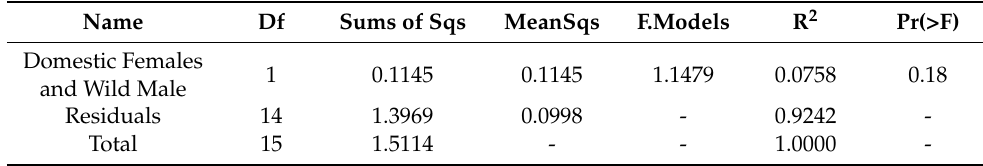
Table A4. Results of the PERMANOVA analysis of the gut microbial diversities between domestic females and wild